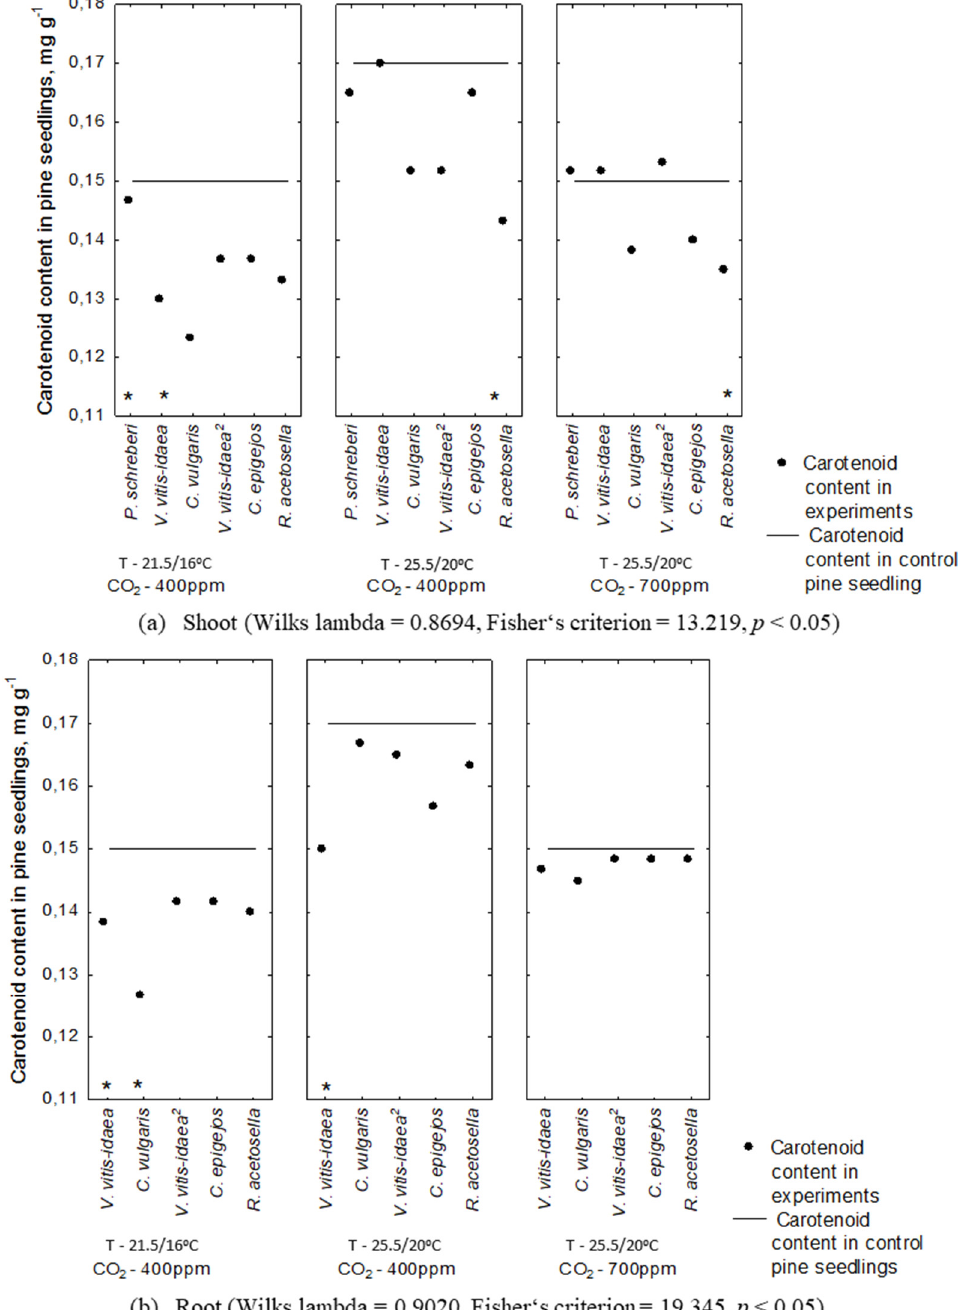
Figure 8. Carotenoid concentration in the Scots pine seedlings under the effect of plant-donor shoot ( a ) and root ( b ) extracts under different CO 2 and temperature conditions (*— p < 0.05 post-hoc LSD test). Control conditions (21.5/16 ◦ C and 400 ppm CO 2 concentration), temperature increases of 4 ◦ C compared to the current conditions (25.5/20 ◦ C and 400 ppm CO 2 concentration), increasing temperature with higher CO 2 concentration conditions (25.5/20 ◦ C and 700 ppm CO 2 ). ( 2 )—dominant species of 2-year-old